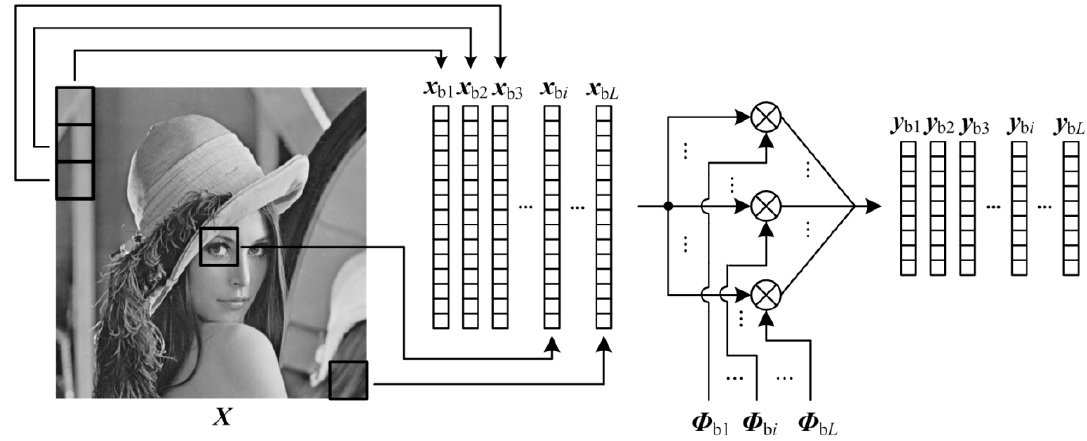
Figure 2. Illustration on BL format.